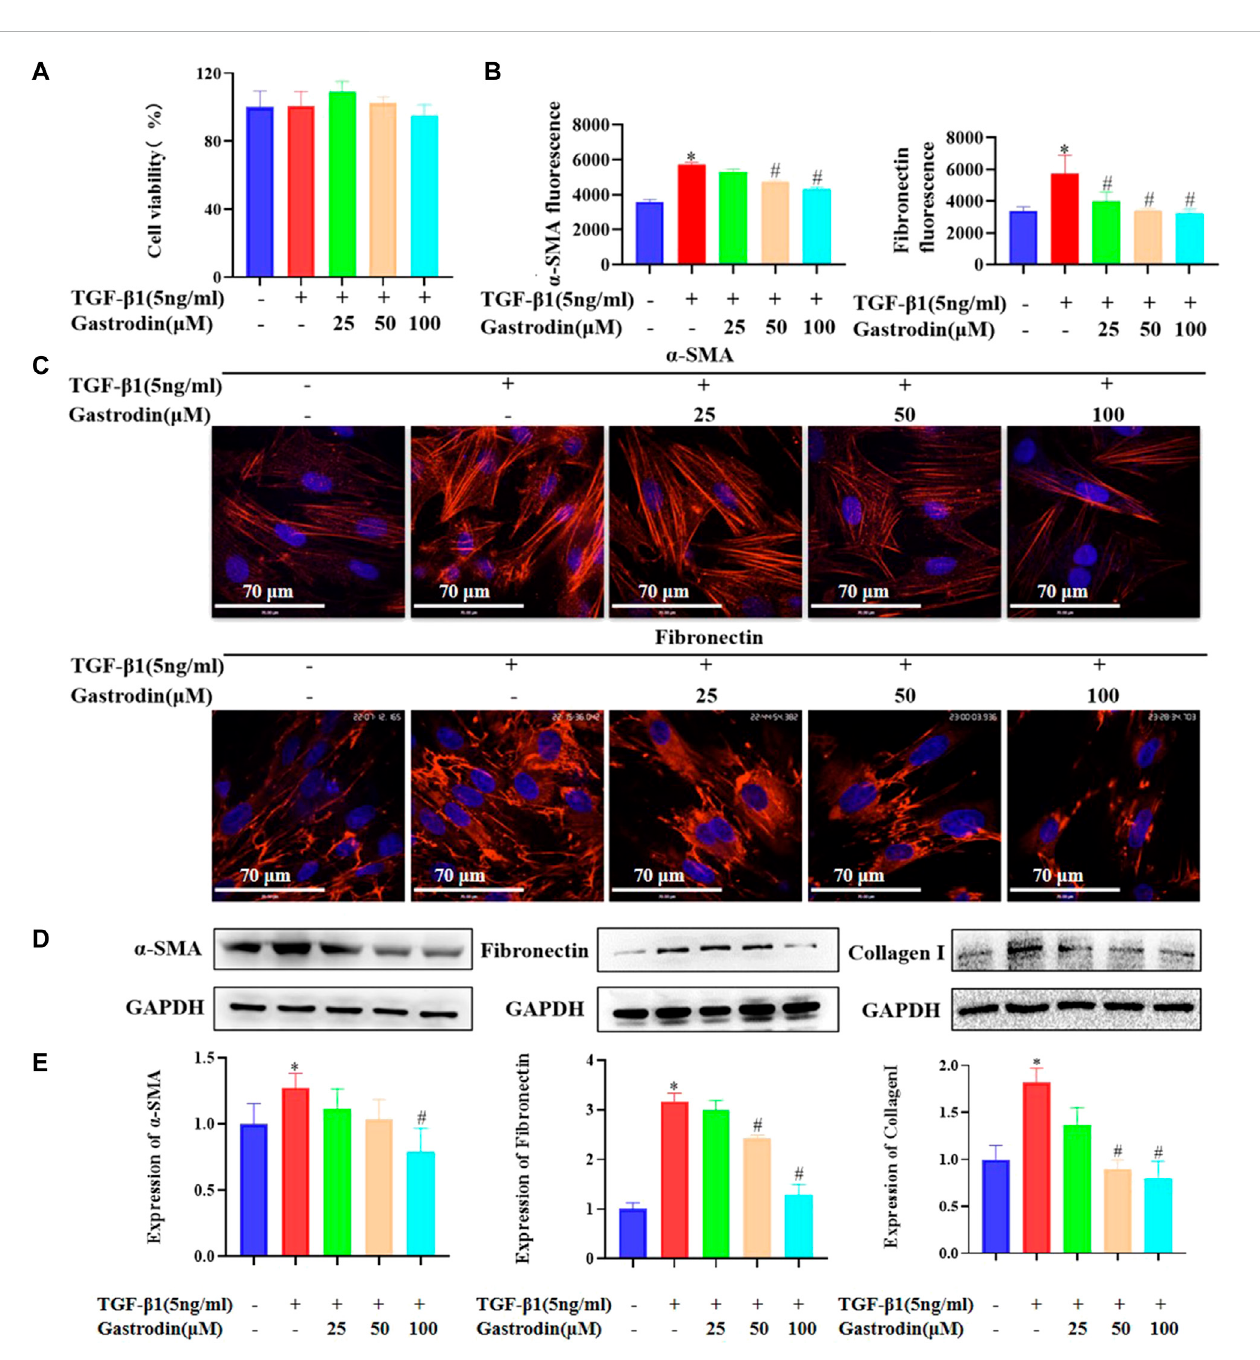
FIGURE 7 Gastrodininhibitedtheexpressionsof α -smooth muscleactin ( α -SMA) and fi bronectin intransforming growth factor- β 1(TGF- β 1)-treatedNRK-49Fcells (A) Viability of NRK-49F cells after treatment with gastrodin and TGF- β 1, as analyzed using the CCK-8 assay. The viability of untreated NRK-49F cells was de fi ned as 100%. Data are mean ± SD ( n = 6 for each group) (B) Relative α -SMA and fi bronectin expressions in each group were determined using ImageJ. All values are mean ± SD ( n = 3 for each group). * p < 0.05 vs the control group, # p < 0.05 vs the TGF- β 1 group (C) Immuno fl uorescence (IF) staining was performed to detect the expressions of α -SMA and fi bronectin (red). The nuclei (blue) were stained with Hoechst. Magni fi cation, ×600 (scale bar 70 μ m)